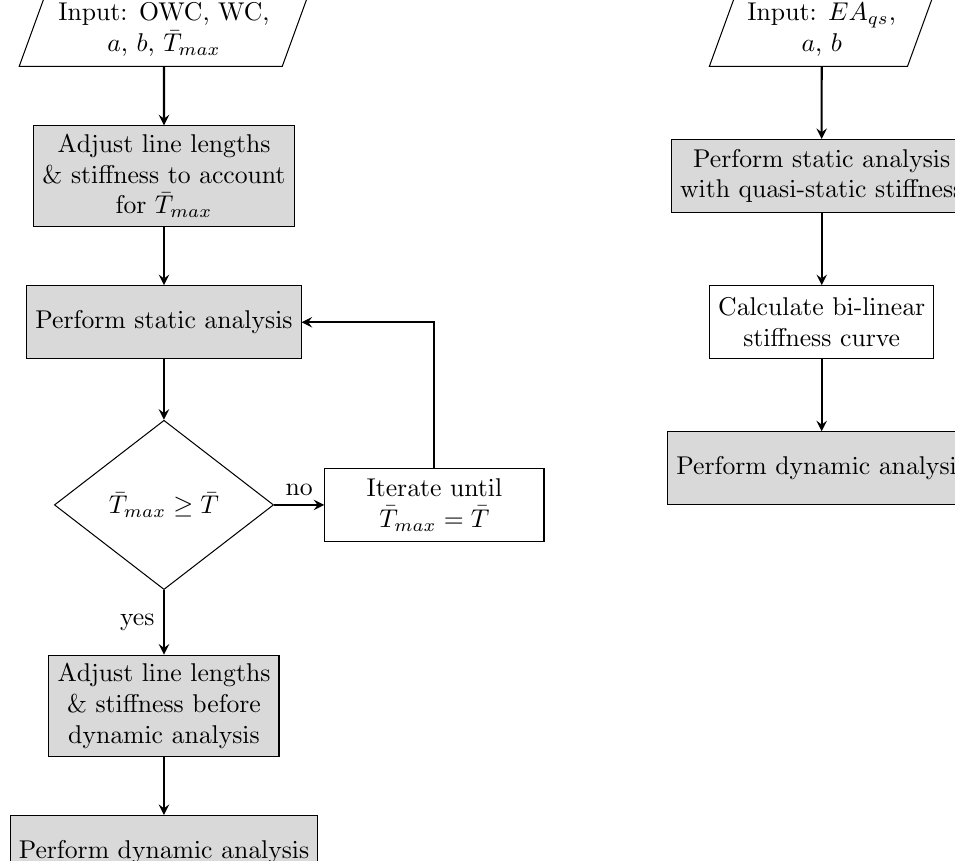
Figure 7. Simulation procedure for updating the mooring line properties for the Syrope model ( left ) and bi-linear model ( right ). The steps in grey are performed in RIFLEX, while the steps in white are performed in SIMA as part of the model and simulation